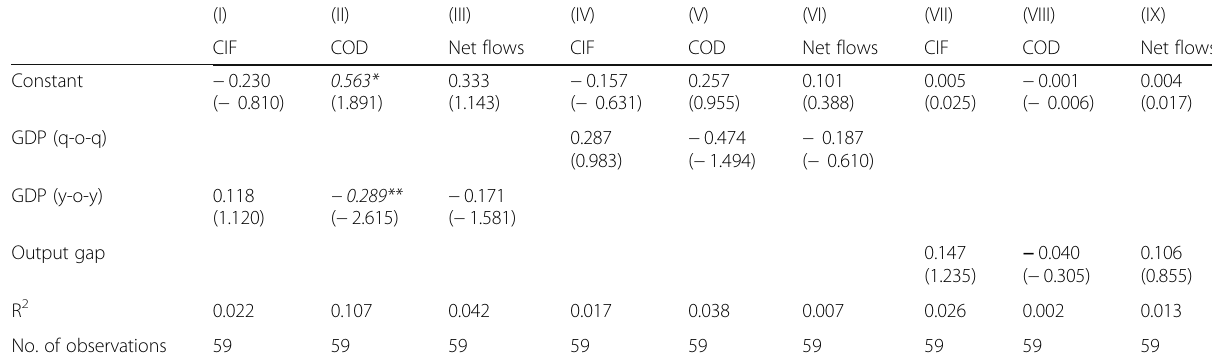
Table 5 Relationship between the domestic economic activity and capital exports and